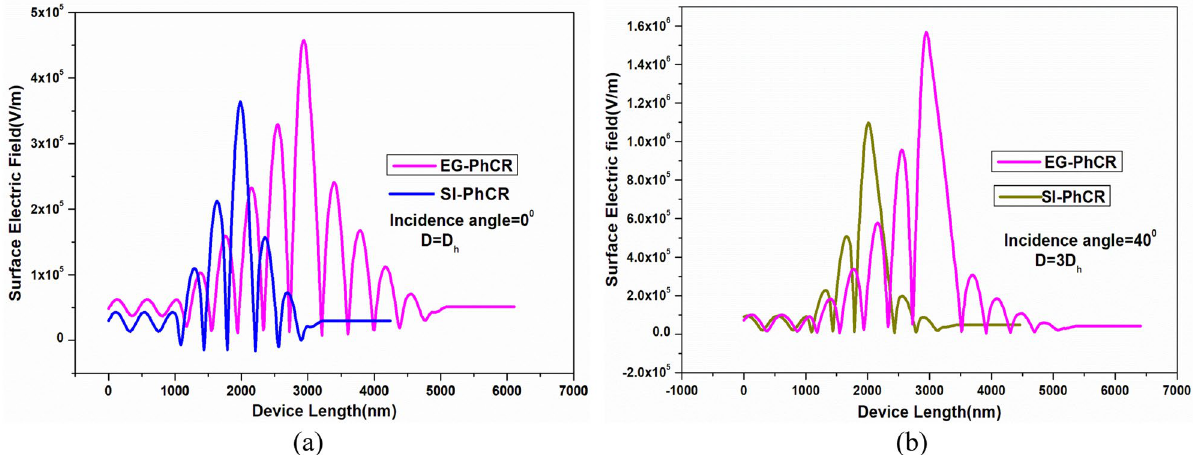
Figure 7. Surface electric field profile comparison of SI-PhCR structure and EG-PhCR structure with defect RI of ‘1’ at ( a ) 0° incidence angle and D h defect layer thickness and ( b ) 40° incidence angle and 3D h defect layer thickness.